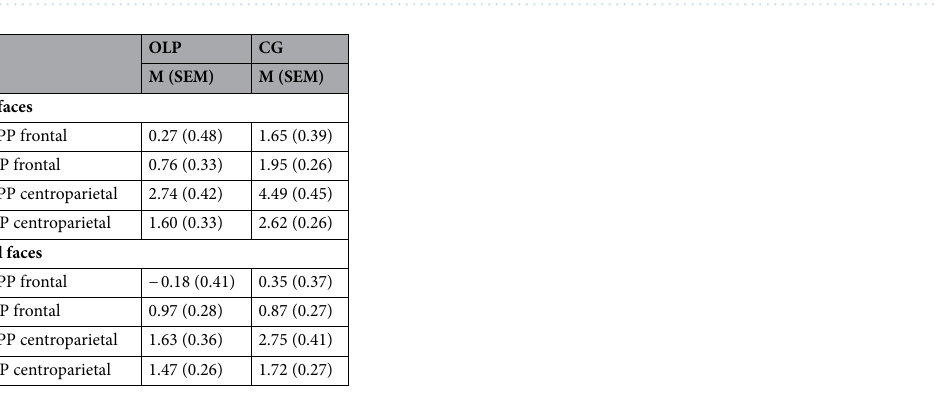
Table 2. Means and standard errors for late positive potentials (early LPPs: 400–1000 ms) and late LPPs (1000–6000 ms) in the open-label placebo (OLP) group and the control group (CG).